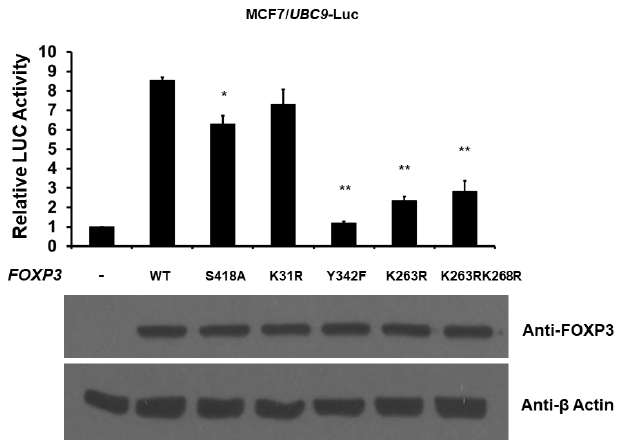
Figure 5. Post-translational modifications of FOXP3 regulate the activation of the UBC9 promoter. MCF7 cells were co-transfected with a reporter plasmid with the UBC9 promoter and either wild-type (WT), S418A, K31R, Y342F, K263R, or K263RK268R FOXP3 expression plasmid. The luciferase activities (LUC) were measured and normalized with Renilla activity, 48 h after transfection. The relative LUC activity (presented as fold activation) was calculated and plotted on a graph. The protein levels of FOXP3 in the MCF7 cells from the reporter assays were confirmed using anti-FOXP3 immunoblotting. The level of β -Actin protein serves as a loading control. The reporter assays were performed three times with similar results. * indicates p < 0.05 vs. WT. ** indicates p < 0.001 vs. WT.